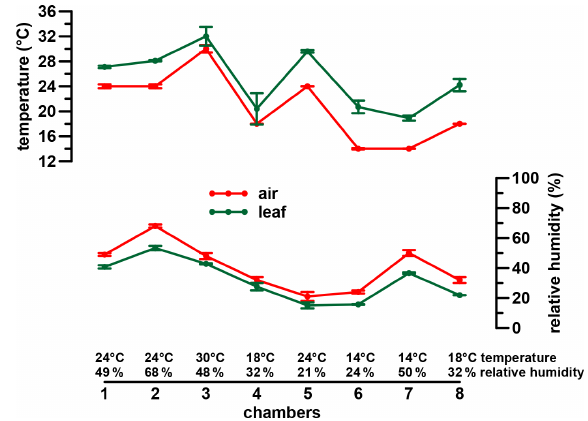
Figure 1. Climate chamber conditions. Error bars represent analyt- ical standard deviation of the respective measurements. For more details see Sect. 2.2 and Mayr